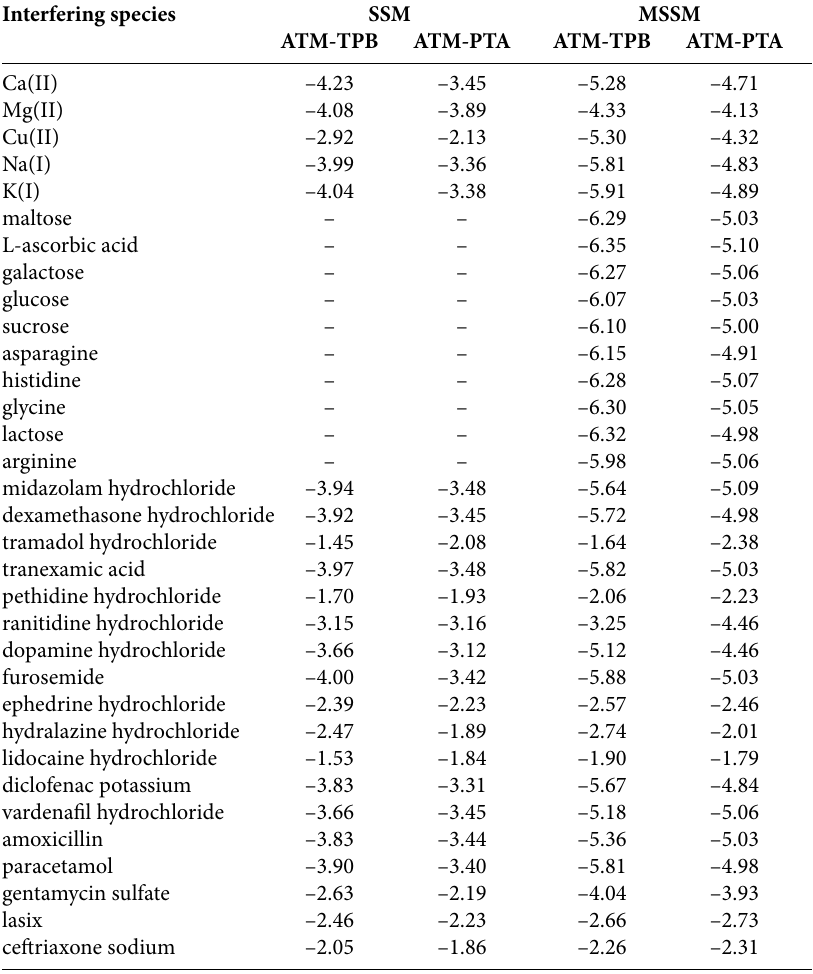
Table 2. Selectivity coefficients of various interfering ions for sensor ATM-TPB and sensor ATM-